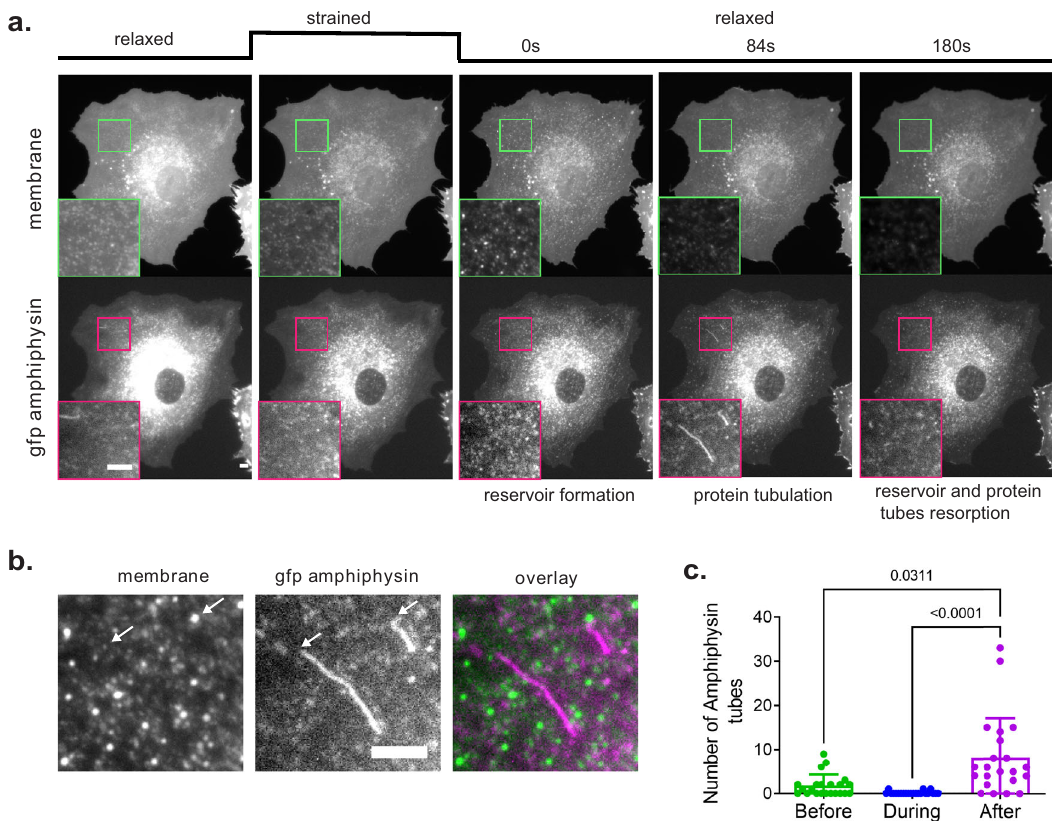
Fig. 4 Mechanical stretch in cells triggers Amphiphysin-mediated tubulation. a Representative images (in both membrane and Amphiphysin channels) of a cell before, during, and after stretch release. b Detail of membrane and Amphiphysin channels during tubulation. c Quanti fi cation of the number of Amphiphysin tubes at rest, during stretch, and once stretch is released ( n = 22, Friedman test (two-tailed)). Data are shown as mean ± s.d., and source data are provided as a Source data fi le. Scale bars, 5 μ